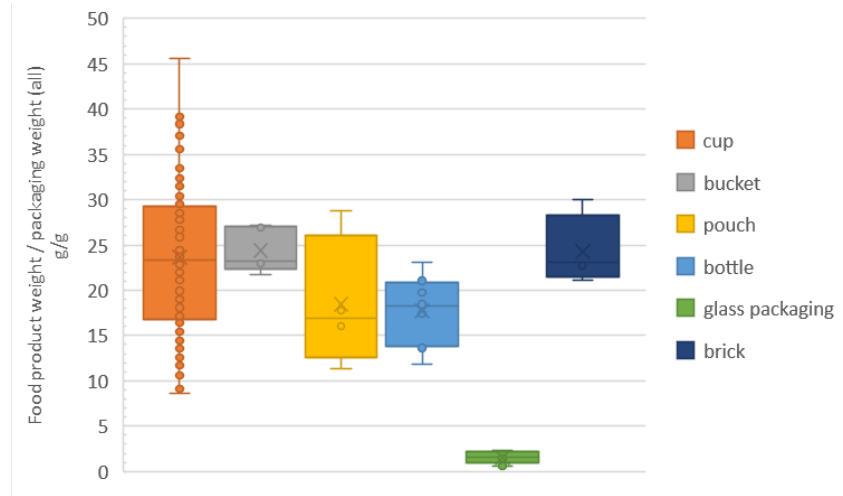
Figure 13. Packaging efficiencies for different types of packaging; packagings include all packaging components (labels, wrappings, shrink sleeves, lid).